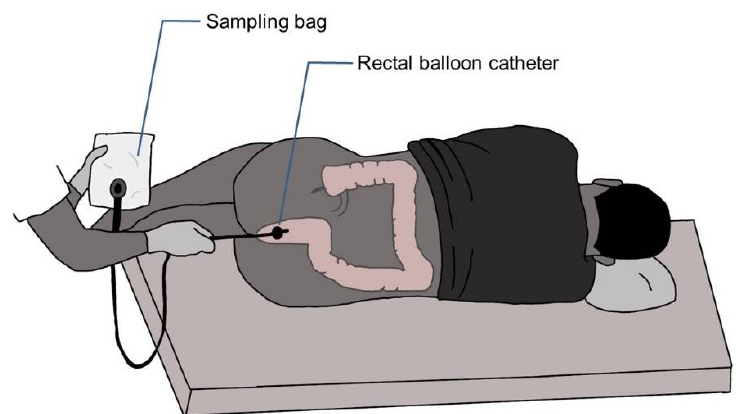
Figure 1. Schema of the rectal gas sample procedure. Rectal gas was collected via a balloon catheter connected directly to a gas collection bag.